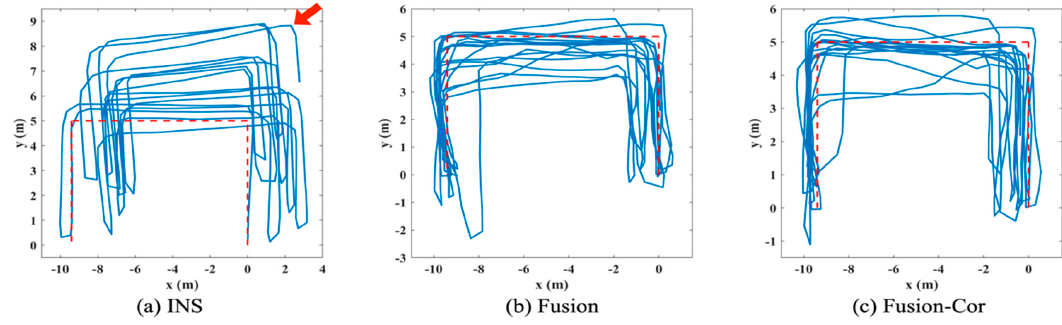
Figure 5. Tracking path for the first experiment.